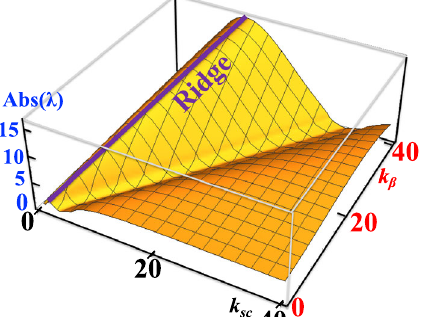
FIG. 3. 3D plot of the absolute value of the growth rate per cell: λ ¼ max ðj Re λ λ 1 j ; j Re 2 jÞ . There is a clearly identifiable ridge − 1 . 2 Þ line, where growth rates peak. along the k β ≅ 3 · ð k sc